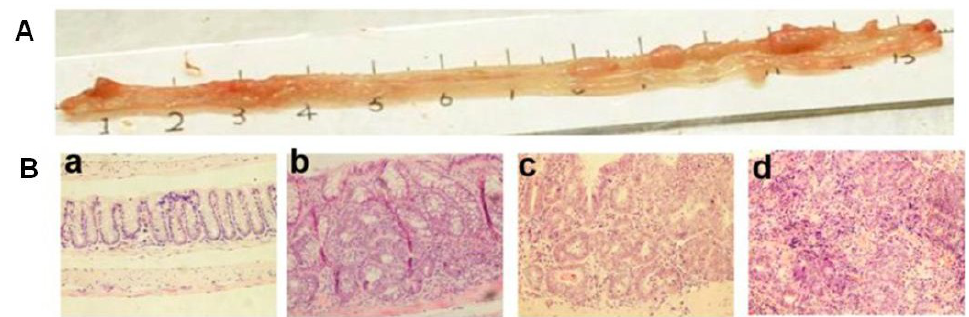
Figure 1. Histopathology of azoxymethane (AOM) / dextran sodium sulfate (DSS)-induced colorectal cancer (CRC) in mice. ( A ) The representative macroscopic appearance of a mouse colon treated with AOM/DSS; ( B ) The representative hematoxylin and eosin stained sections showing different histopathology of mouse colon, including normal ( a ), dysplasia ( b ), adenoma ( c ), and adenocarcinoma ( d ).